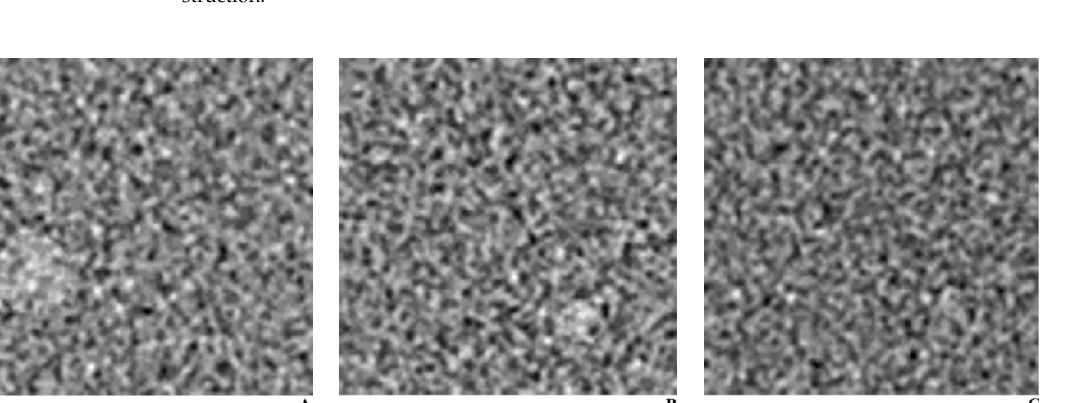
Figure 1. Representative images for the training set. CT phantom images with an artificially generated object of ( A ). 12 mm size at the left lower quadrant with a 10 HU difference to the background, and ( B ). 7 mm size object at the right lower quadrant with a 10 HU difference to the background, and ( C ). an image without any object.